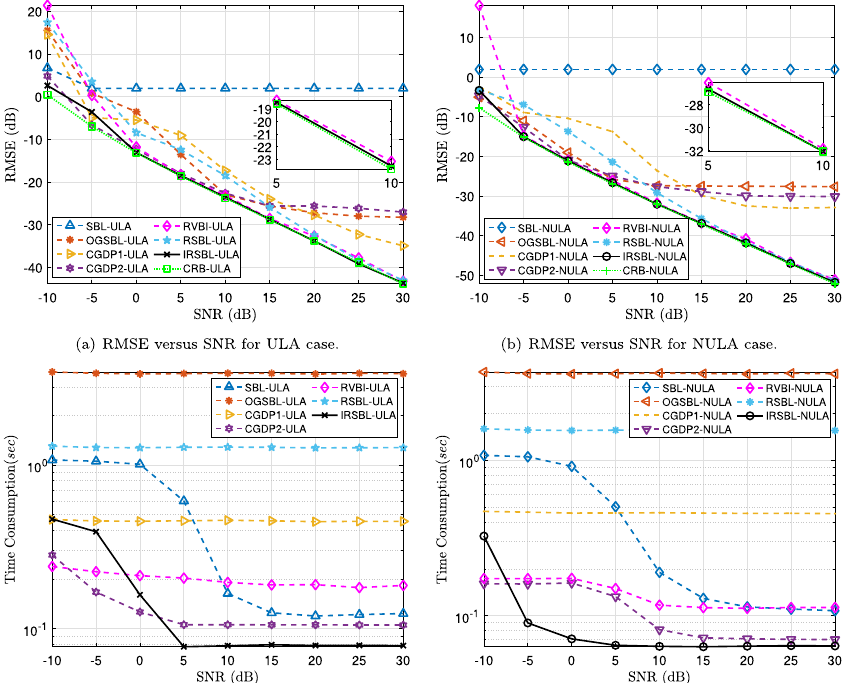
Fig. 7 Performance comparison among SBL, OGSBL, CGDP1, CGDP2, RSBL, IRSBL methods for different SNR